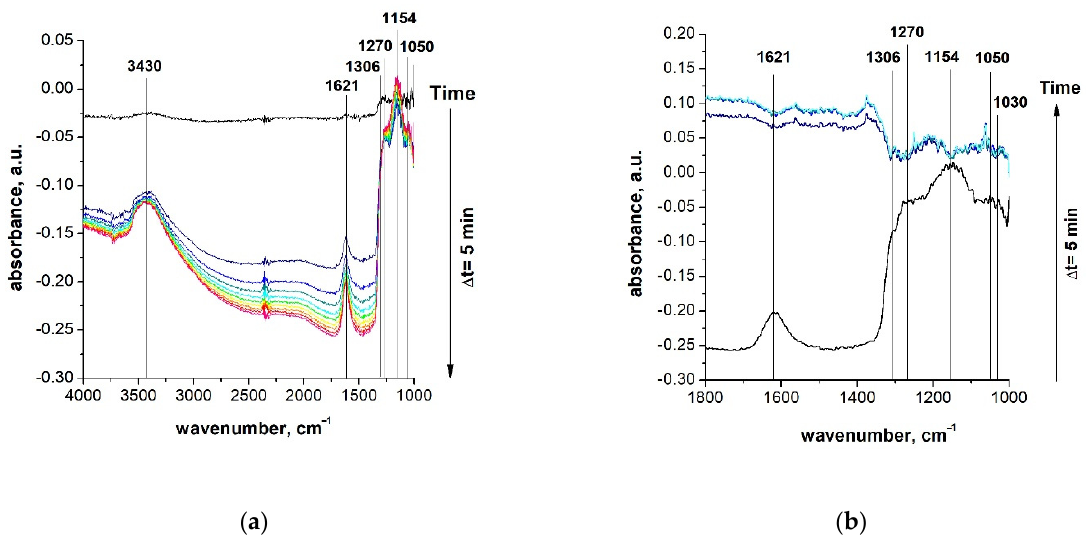
Figure 11. Co 3 O 4 DRIFT spectra: ( a ) 20 ppm H 2 S in humid air (60% R.H.) at 220 °C; ( b ) Annealing in humid air (60% R.H.) at 300 °C.